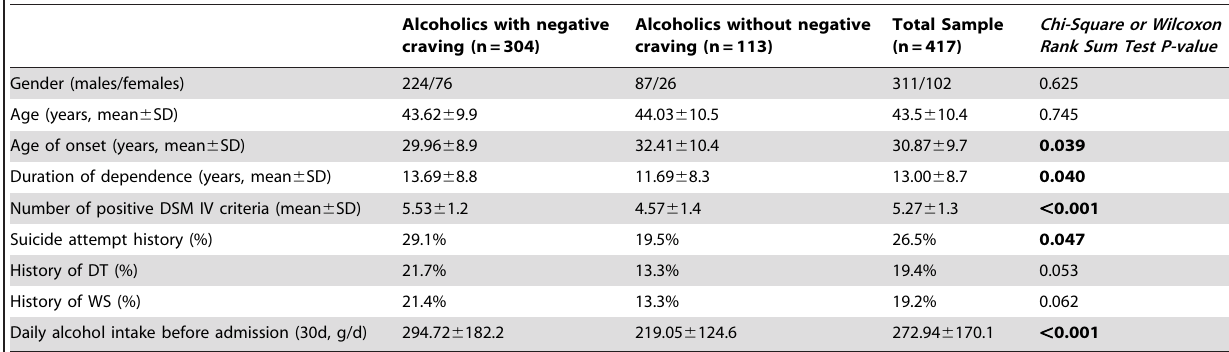
Table 1. Characteristics of alcohol-dependent individuals with and without negative craving.